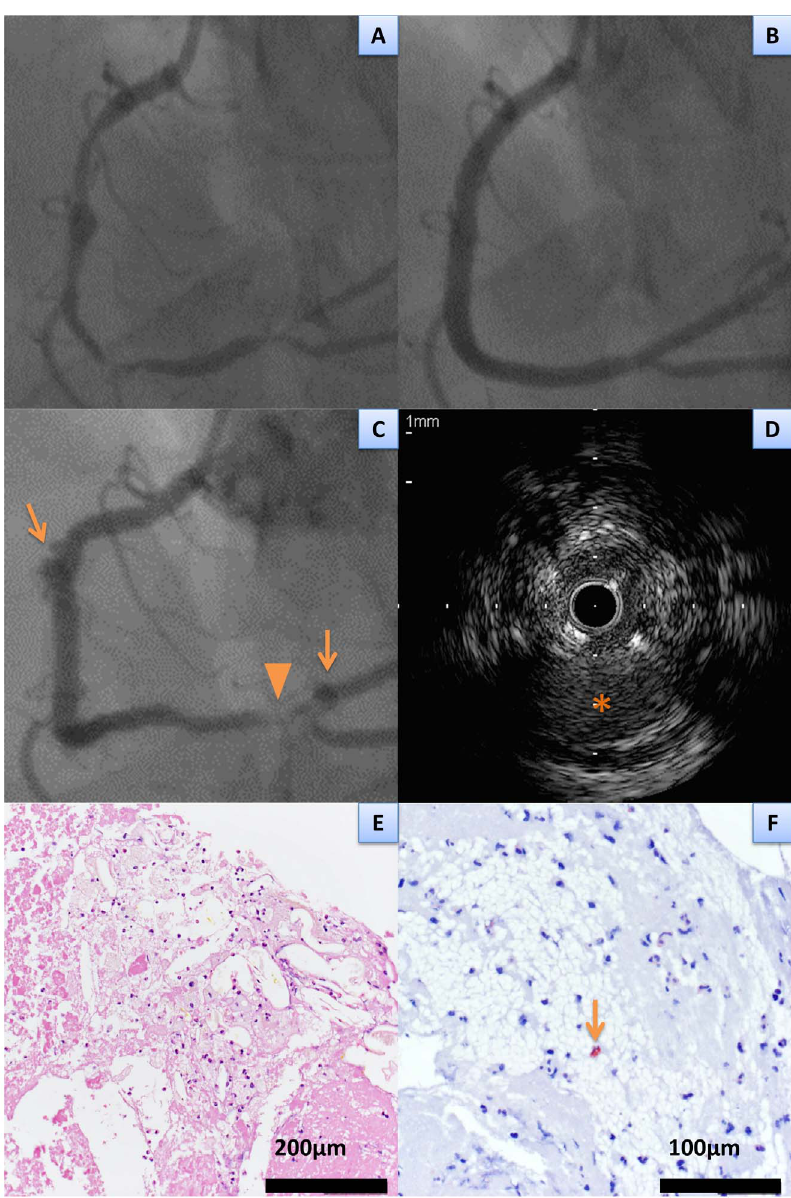
Figure 4. A representative case of very late stent thrombosis with fragments of atherosclerotic plaques retrieved from lesions with peri-stent contrast staining and incomplete stent apposition. A , B pre and post coronary angiography for 3 sirolimus-eluting stents implantation in the right coronary artery. C , very late stent thrombosis occurred at 1317 days after the index procedure. Peri-stent contrast staining ( arrows ) was found in the proximal and distal bifurcation lesions in the right coronary artery. Radiolucency ( arrow head ) suggesting the presence of thrombus was found in the distal bifurcation lesion. D , Intravascular ultrasound demonstrated intra-stent thrombus and incomplete stent apposition with positive arterial remodeling (asterisk). E , cholesterol crystals with foamy macrophages were observed in the aspirated thrombus (hematoxylin and eosin stain). F , eosinophils (arrow) were sparsely observed in the aspirated thrombus (1.9% out of total white blood cells) (Luna